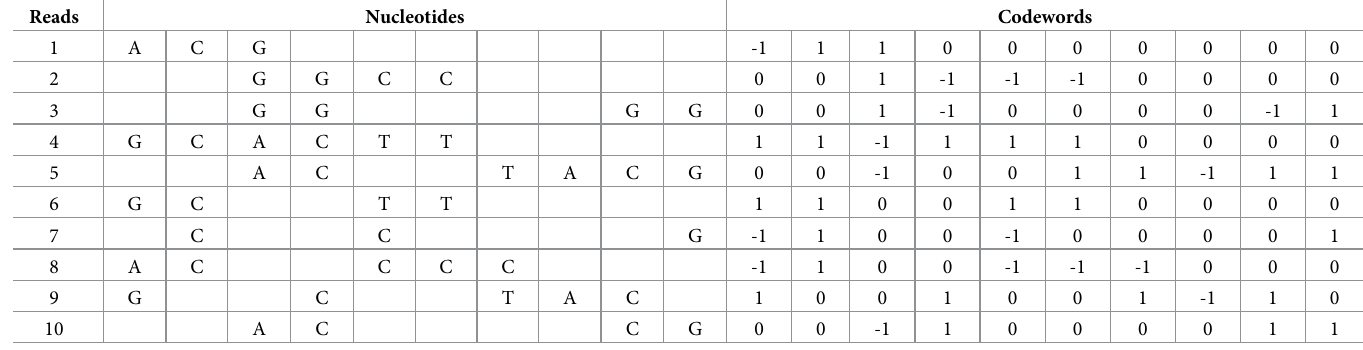
Table 2. Example of aligned reads for β 2 AR genes and the considered codewords.